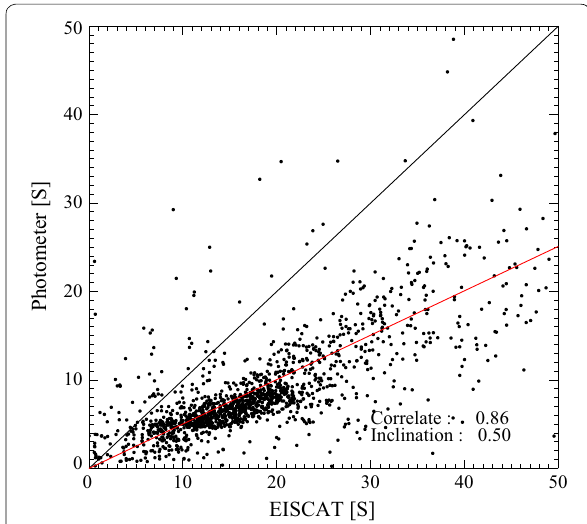
Fig. 11 Scatter plot of height-integrated Hall conductivity for Octo- ber 11, 2002; the same as Fig. 9 except for the height-integrated Hall